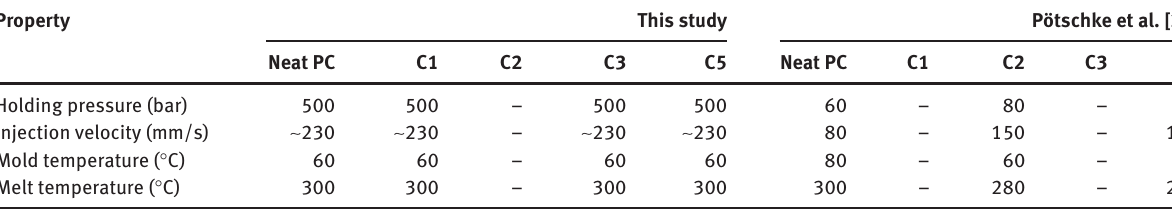
Table 8 Comparison of injection molding parameters with Pötschke’s study [21]. Property